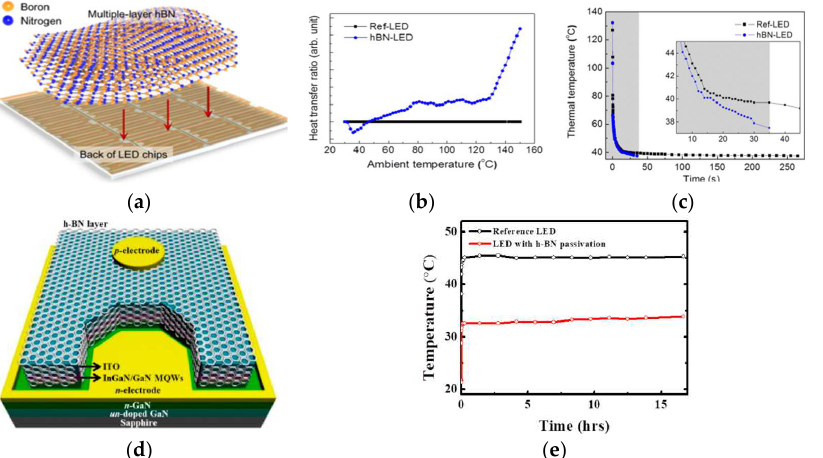
Figure 6. ( a ) Schematic representation of the transfer process of multiple-layer h-BN onto the back of an LED wafer. ( b ) HTR values of the LEDs as a function of ambient temperature, obtained from DSC experiments. ( c ) Tmax as a function of time after stopping the injection of current into the LED chips [47]. ( d ) Schematic diagram of fabricated InGaN/GaN-based light-emitting diode (LED) with hexagonal boron nitride (h-BN) film as a passivation layer. ( e ) Operation temperatures on both devices as a function of operation time at 100 mA [49].